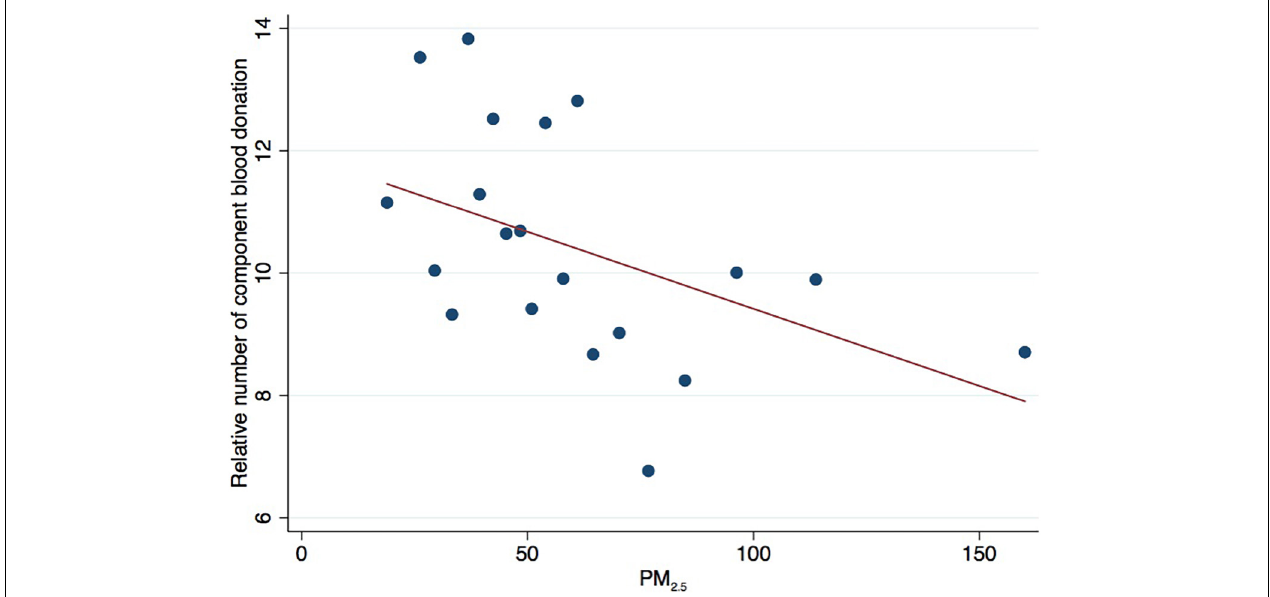
FIGURE 1 | Binned scatter relationship between PM 2 . 5 and relative number of component blood donation.